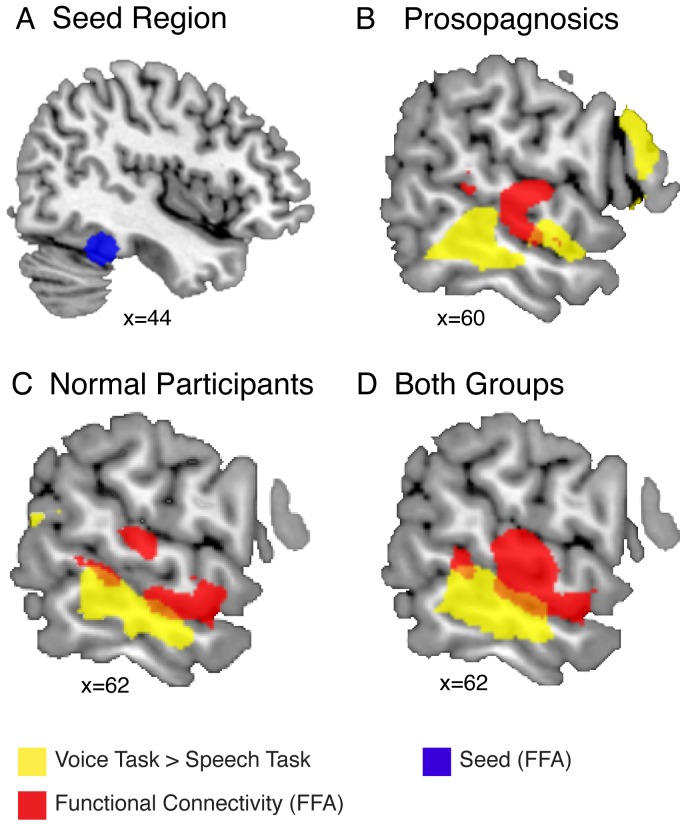
Functional connectivity of the FFA (seed) and the voice-sensitive areas in the right STS.(A) On the coronal slice, the blue sphere schematically illustrates the FFA for the group average. FFA seed regions were determined for individual participants. (B) Overlay of functional connectivity (PPI) and voice-sensitive areas is shown for prosopagnosics, normal participants (C) and both groups together (D). Clusters with increased functional connectivity (learning type x task: (voice task/voice-face>voice task/voice-occupation)>(speech task/voice-face>speech task/voice-occupation)) to the FFA are shown in red. Voice-sensitive areas identified by the task-related activity contrast (voice task>speech task) are shown in yellow.